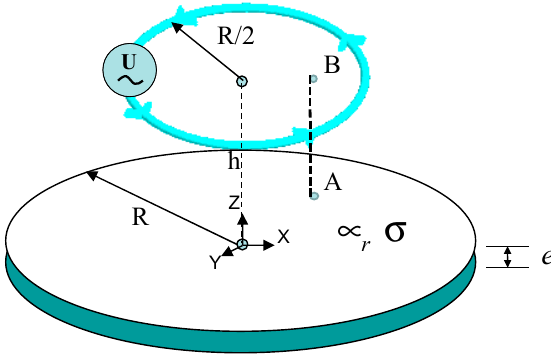
Figure 3. Thin magnetic conductive disk and conductor.